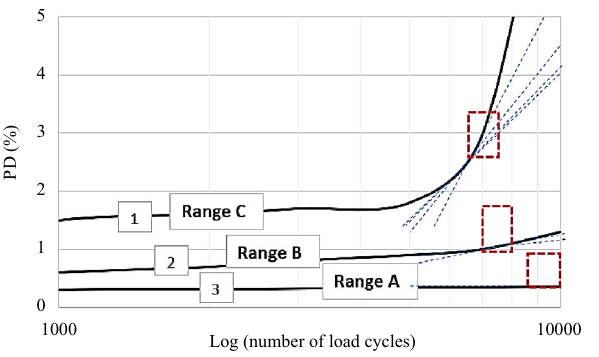
Fig. 11 Proposed shakedown criteria Table 8 New boundaries for the shakedown ranges Range